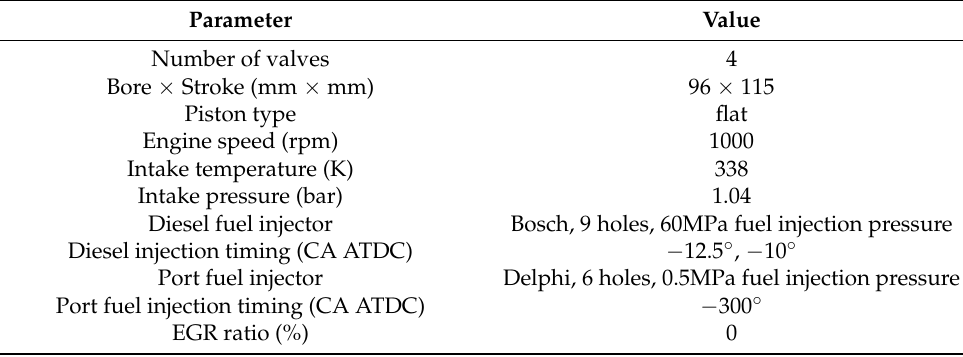
Table 2. Dual-fuel engine specifications and operating conditions.